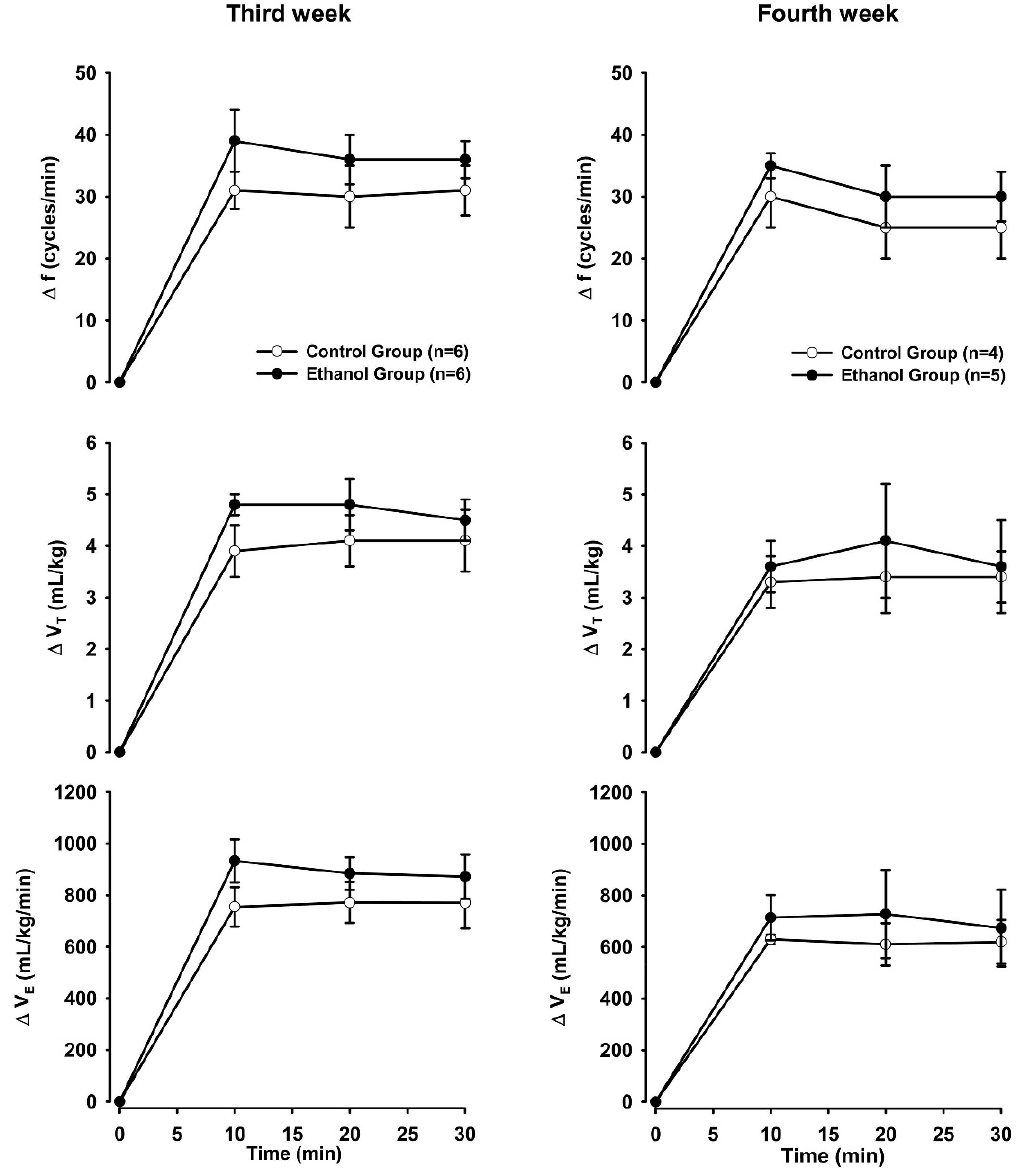
Figure 5 - Changes during the third (left panel) and fourth (right panel) weeks in respiratory frequency (f, top), tidal volume (V T , middle) and minute ventilation (V E , bottom) in response to 7% CO 2 -mediated hypercapnia in rats receiving water (control group) or ethanol (ETOH) in increasing concentrations (first week: 5% v/v, second week: 10% v/v, third and fourth weeks: 20% v/v). Values